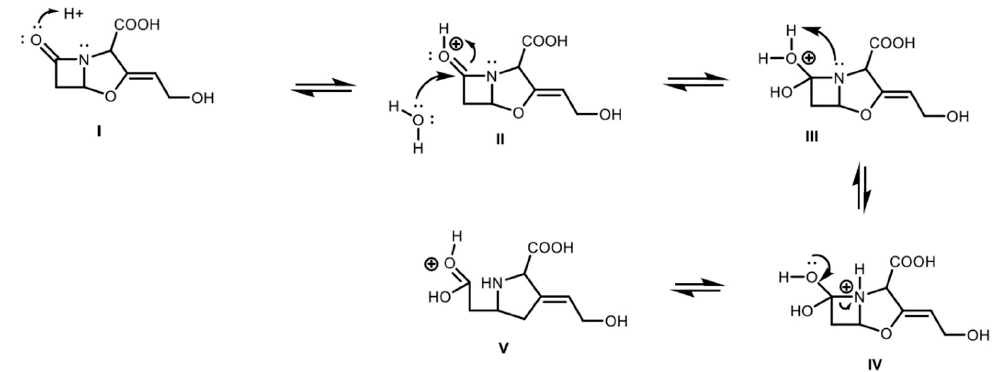
Figure 4. Early steps of CA degradation: (I). Protonation of carbonyl group in the β -lactam ring. (II). Nucleophilic attack of water to carbonyl group. (III). Deprotonation of water–protonation of the nitrogen. (IV–V). Breaking of C–N bond in the β -lactam ring.